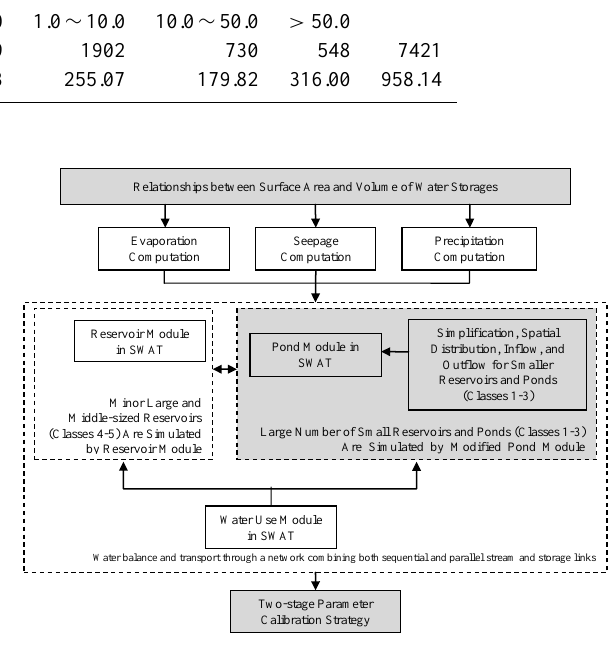
Fig. 1. Framework for the improved Fig. 1 Framework for the improved SWAT2005